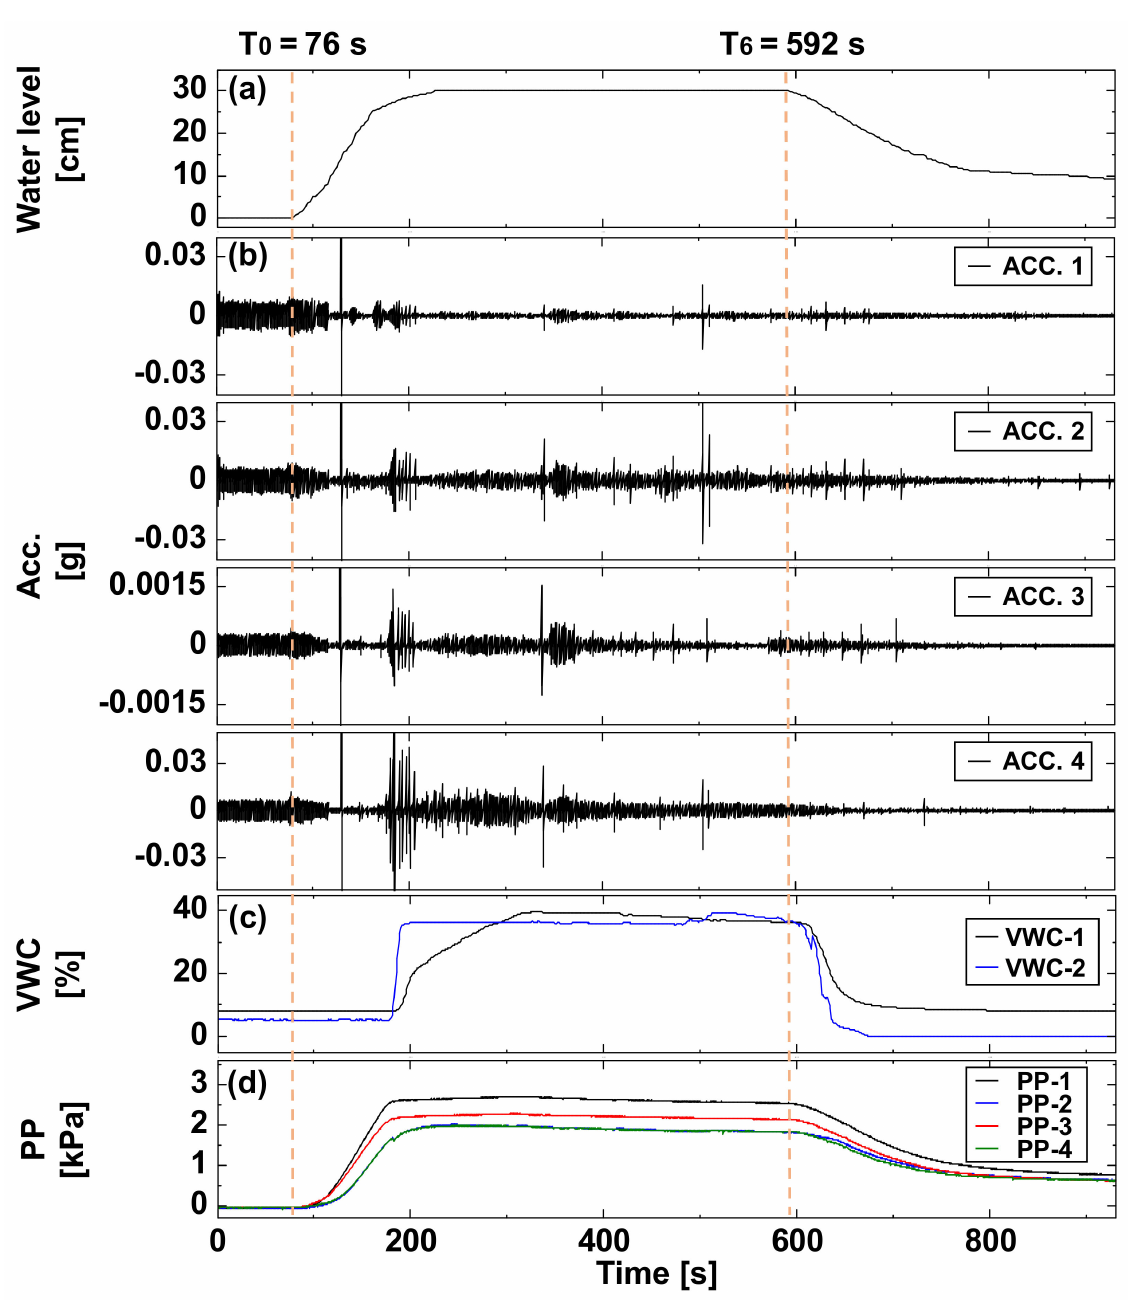
Figure 5. Test measurements: ( a ) water level of the tank, ( b ) seismic signal of Acc. 2, ( c ) volumetric water content, ( d ) pore